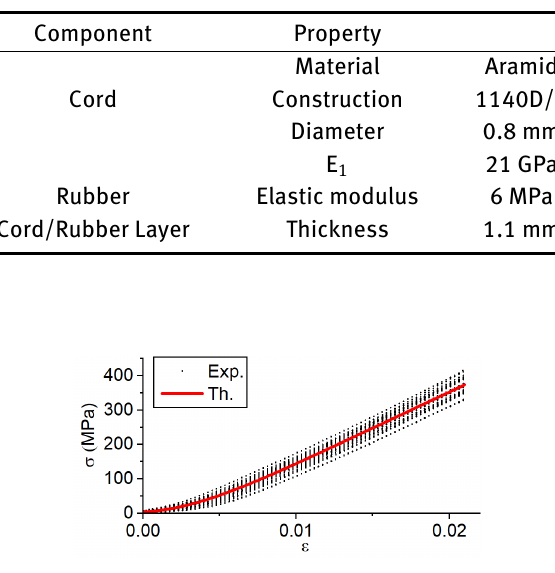
Table 3: Properties of cord/rubber layer.